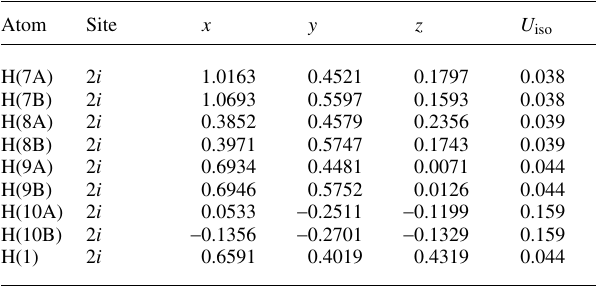
Table 2. Atomic coordinates and displacement parameters (in Å 2 )